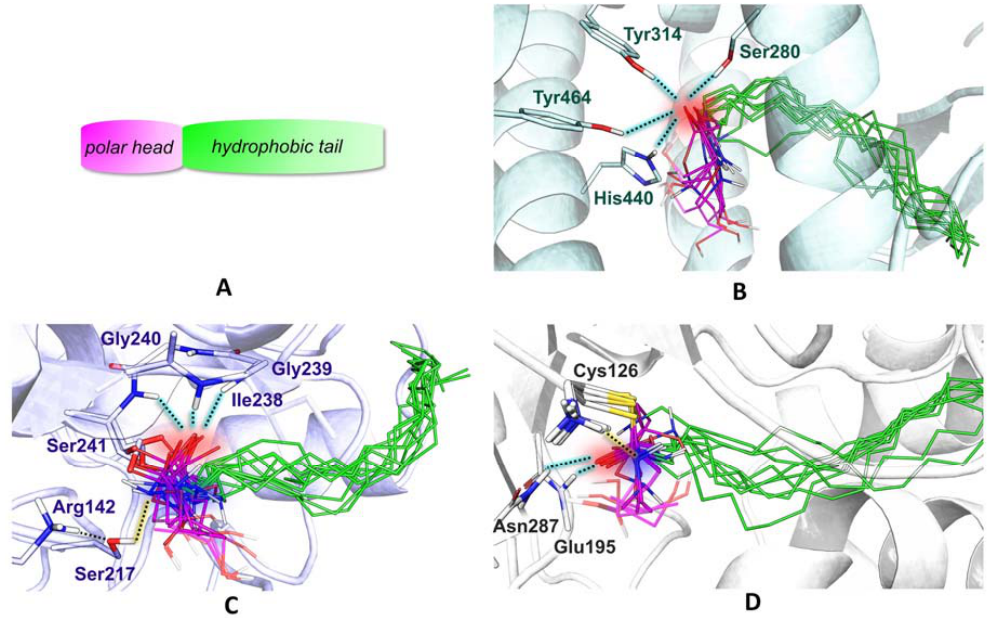
Figure 2. ( A ) Schematic scaffold of PEA and analogues 2 − 10 . They all feature a polar head, which is represented in pink, and a hydrophobic tail, in green. ( B ) Docking poses of PEA and analogues 2 – 10